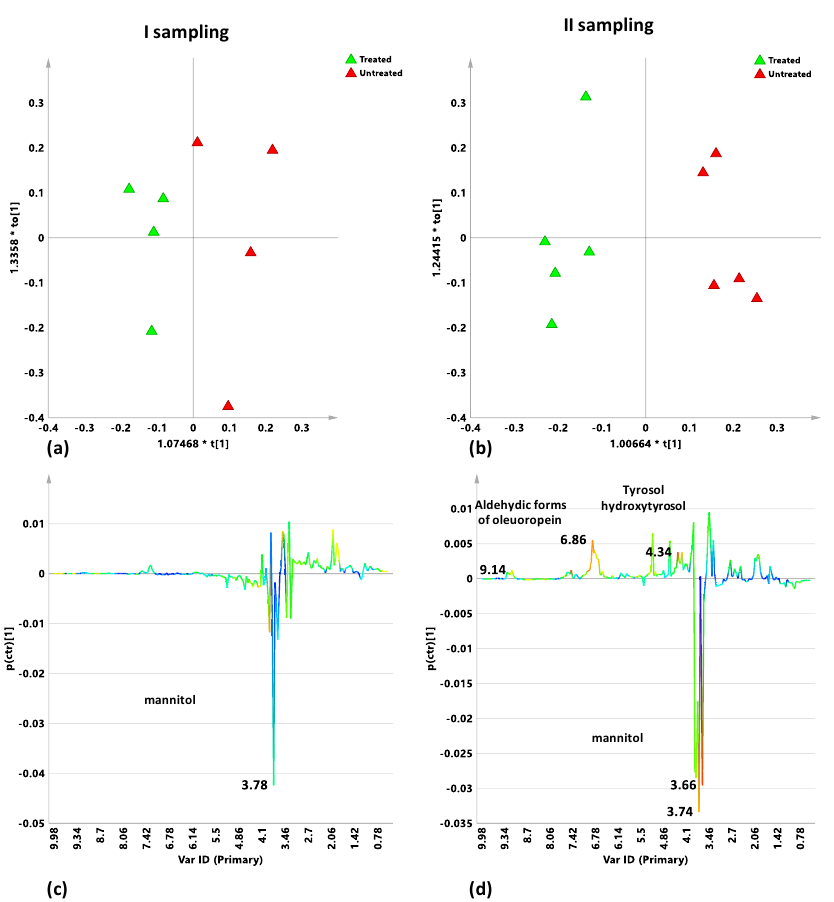
Figure 4. OPLS-DA t[1]/t[2] scores plot for infected control (red triangles) and Dentamet ® -treated (green triangles) Ogliarola salentina leaf samples from I ( a ) and II ( b ) samplings. S-line plots for the I ( c ) and II ( d ) sampling related models visualizes the p(ctr)[1] loading colored according to the absolute value of the correlation loading, p(corr)[1].